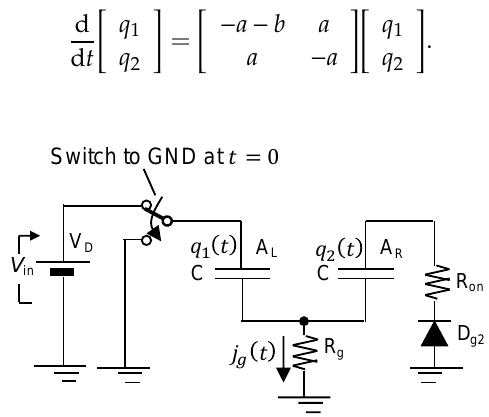
Figure 4. Extracted circuit to derive theoretical model.